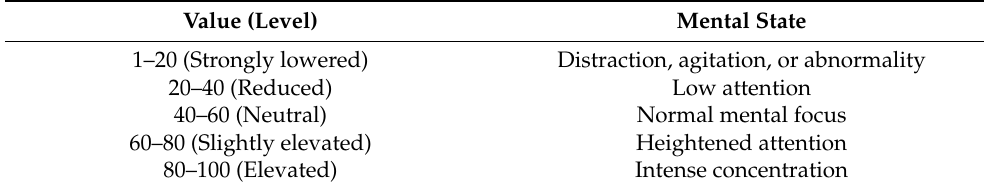
Table 1. Category of Attention eSense TM